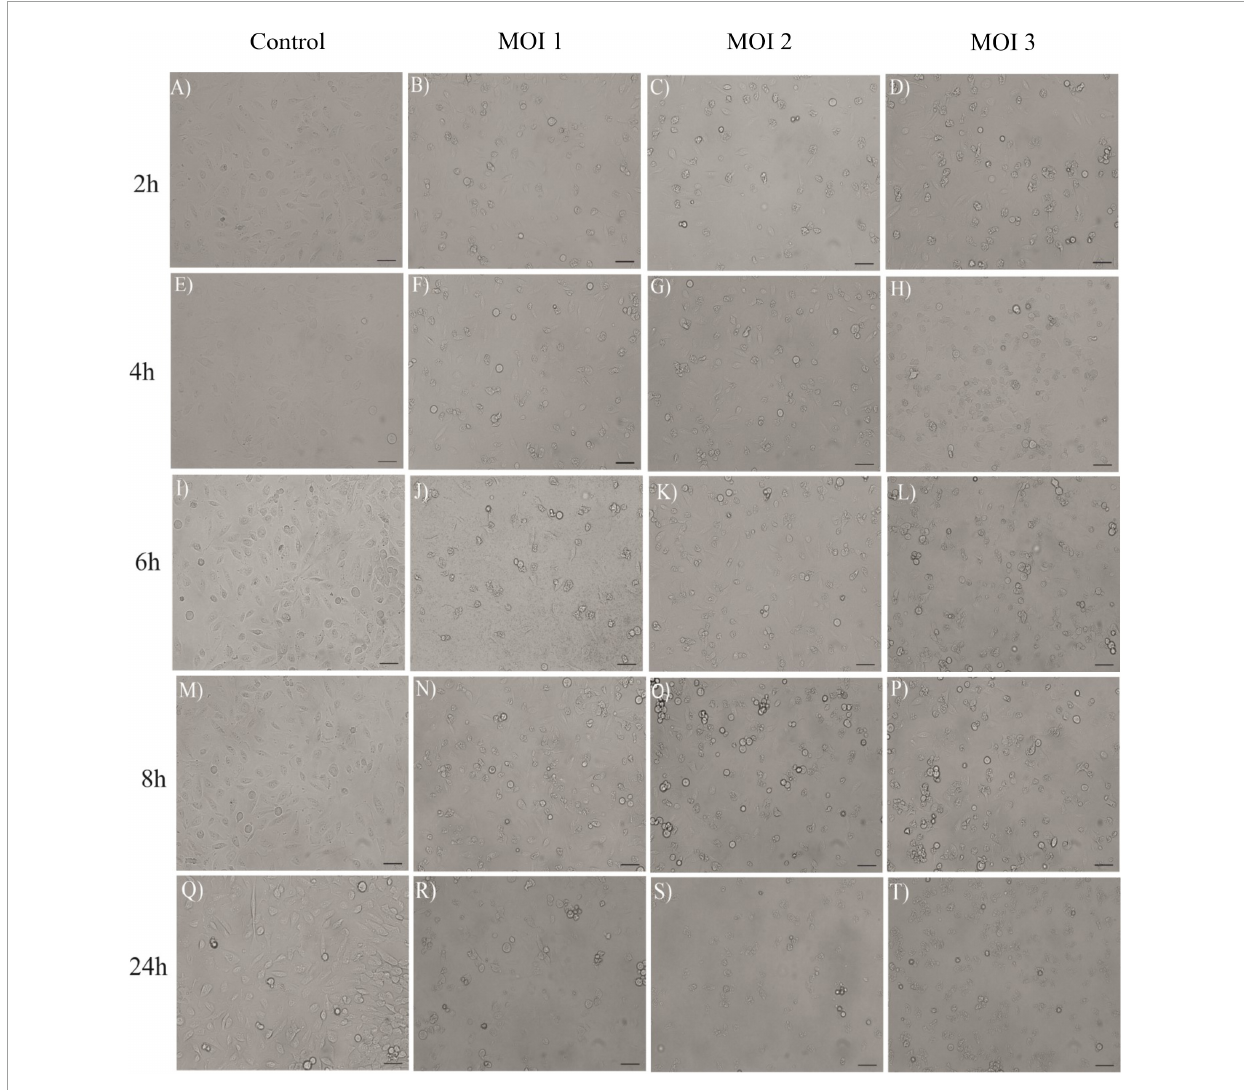
FIGURE6 Effect of Acanthamoeba strain SIN20 after co-culture with HCECs, at MOI 1 (B,F,J, N,R) , MOI 2 (C,G,K,O,S) and MOI 3 (D,H,L,P,T) and at different times (2, 4, 6, 8, and 24 h). Panels (A,E,I,M,Q) represent the HCEC alone without co-culture. Scale bar = 50 µ m. See Supplementary material for the amoeba